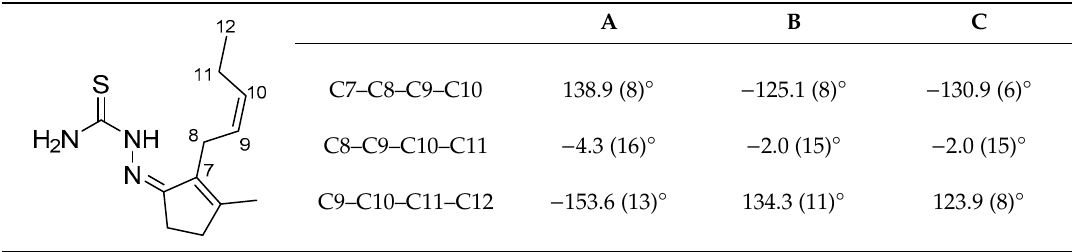
Figure 1. ( A ) Overlapping of molecules A/B (left) and A/C (right). ( B ) Hydrogen bonding scheme between molecule A and B. ( C ) Hydrogen bond scheme along the ribbons formed by molecules A/B. ( D ) packing of the ribbons. Sulfur is represented in yellow, nitrogen in blue and carbon in gray. Table 1. The different hydrophobic chain dihedral angles for the three independent molecules.